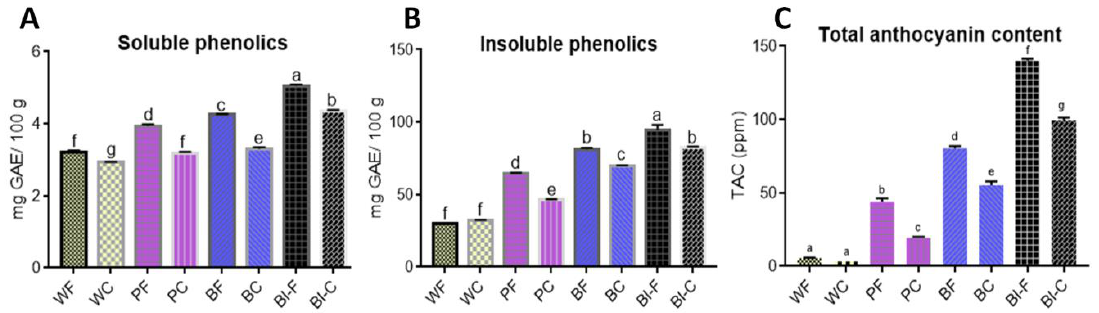
Figure 2. Phytochemical analyses of flour and chapatti samples ( A ) Soluble phenolics content ( B ) Insoluble phenolics content ( C ) Total anthocyanin content of flour and chapatti. All values are expressed as mean ± S.D. Columns labeled with different letters are significantly different ( p < 0.05). WF-white wheat flour, PF-purple wheat flour, BF- blue wheat flour, Bl-F- black wheat flour, WC-white wheat chapatti, PC-purple wheat chapatti, BC-blue wheat chapatti and Bl-C-black wheat chapatti.